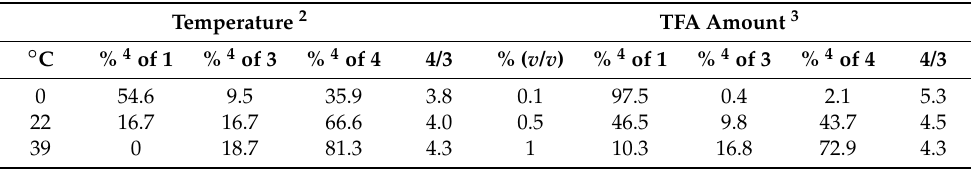
Table 1. Cyclisation of xanthohumol ( 1 ) with TFA under different reaction conditions 1 . Temperature 2 TFA Amount 3 ◦ C % 4 of 1 % 4 of 3 % 4 of 4